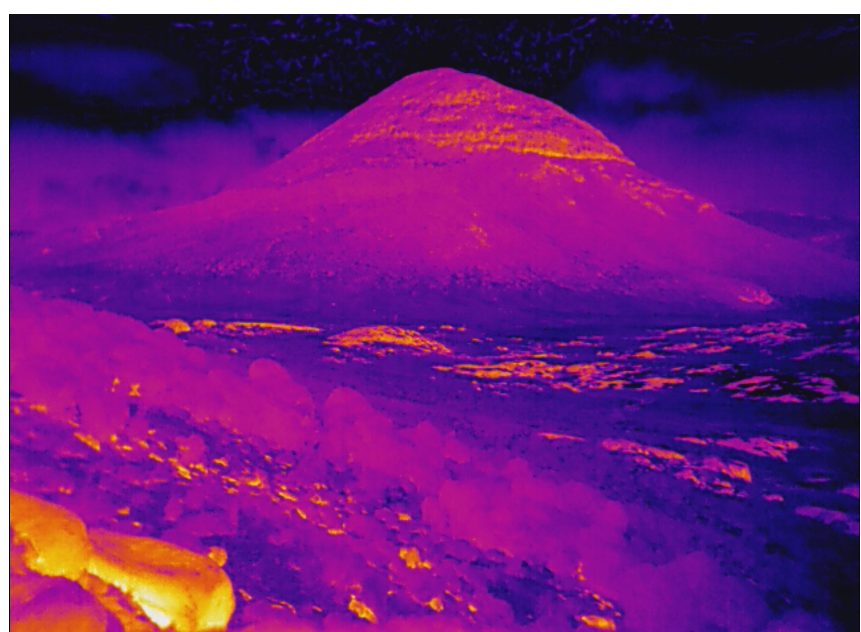
Figure C1. Thermal infrared photo of the Wasama Valley from 23 January 2020 at about 05:30 local time (EAT). Orange to red colours indicate higher temperatures, whereas blue to black colours show lower temperatures. The location of the camera was close to the ground temperature logger TM03t (see Fig. 1). The view is to the east. The valley drains from the left and right in the photo background to the lowest areas in the bottom right. The corresponding thermal infrared time-lapse video is included in the Zenodo repository (Groos et al., 2022) and can be watched online: https://vimeo.com/676294827 (Groos, 2022).